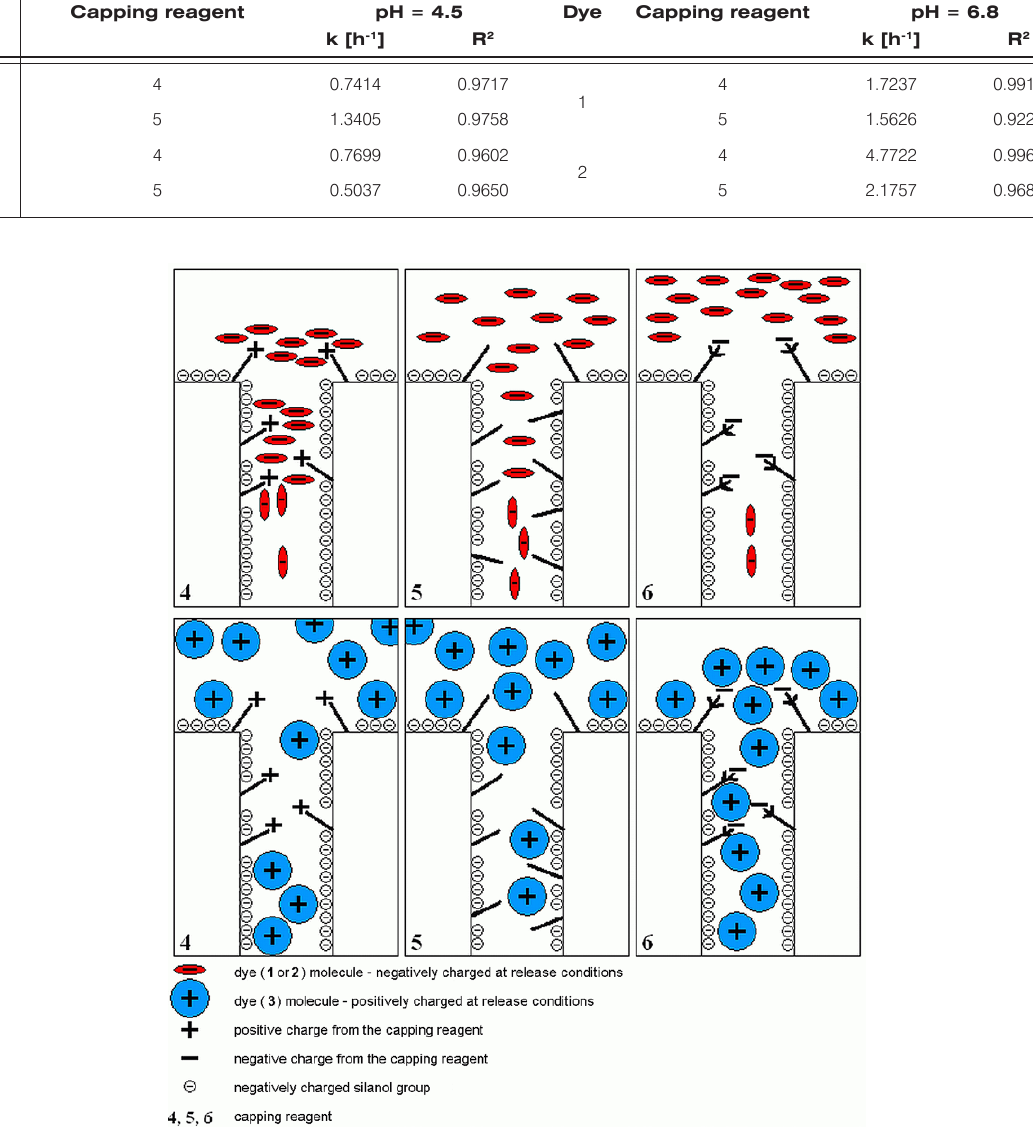
Figure 12. The interactions between the molecules of capping reagents and those of the dyes trapped in the MCM-41 silica channels and on its outer surface – channel diameter and size of the molecules match.